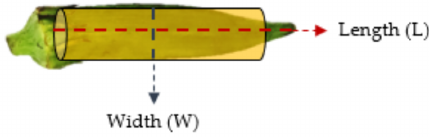
Figure 4. Geometry of an okra pod